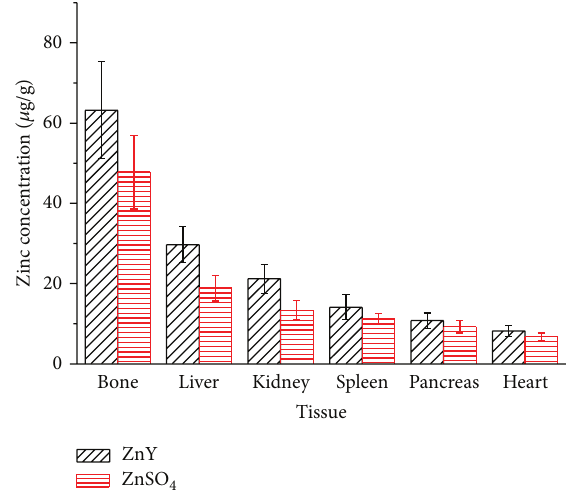
Figure 2: Distribution profiles of ZnY and ZnSO 4 in rat tissues at 24 h after a single oral administration of zinc compounds at a dose level of 4mg Zn/kg ( 𝑛 = 3